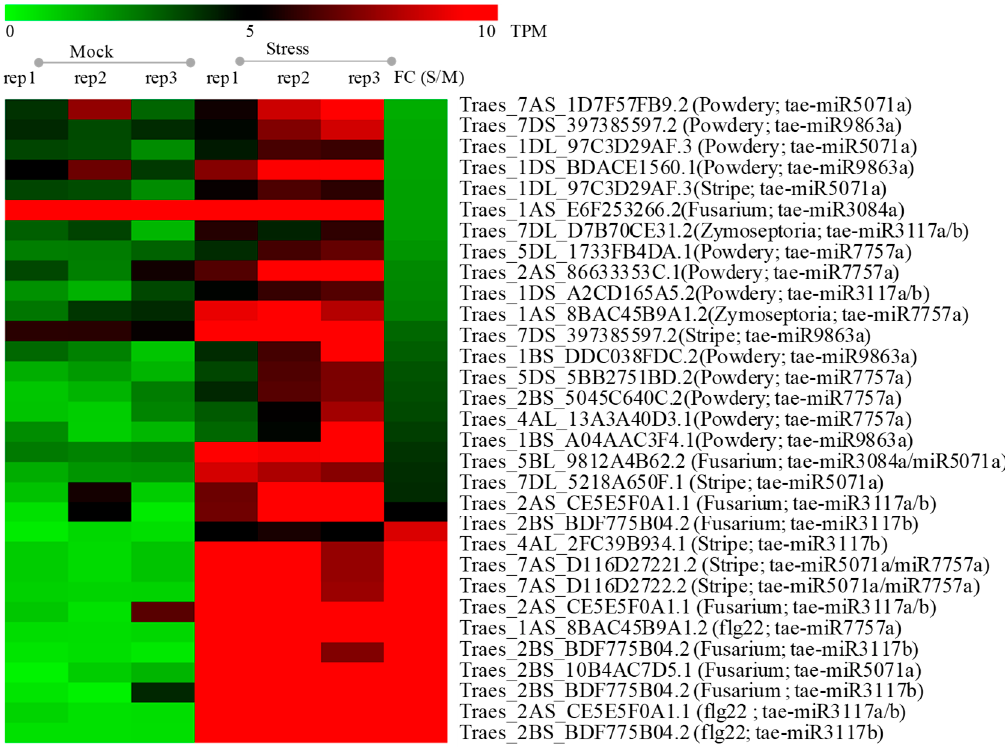
Figure 6. The heat map of target genes between the samples of mock and pathogen stress with three replicates. FC (S/M): Fold change (Stresses (rep1 + rep2 + rep3)/Mocks (rep1 + rep2 + rep3)). Fusarium, Fusarium graminearum ; Powdery, Powdery mildew ; Stripe, Stripe rust ; Zymoseptoria, Zymoseptoria tritici .